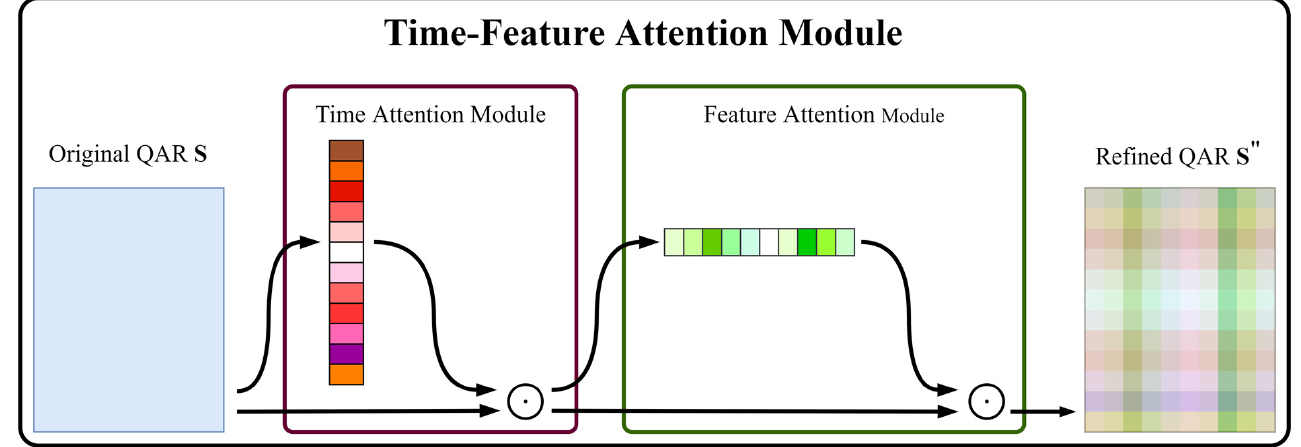
Figure 4. Diagram of the overview of the time-feature attention module.